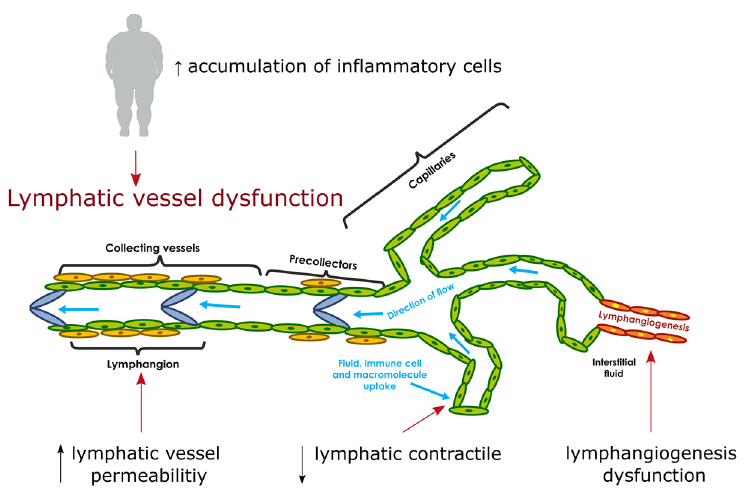
Figure 1. Dysfunction of the lymphatic system in obesity. Modified Figure 1 [24]. Abbreviations: ↑ —increase, ↓ —decrease.